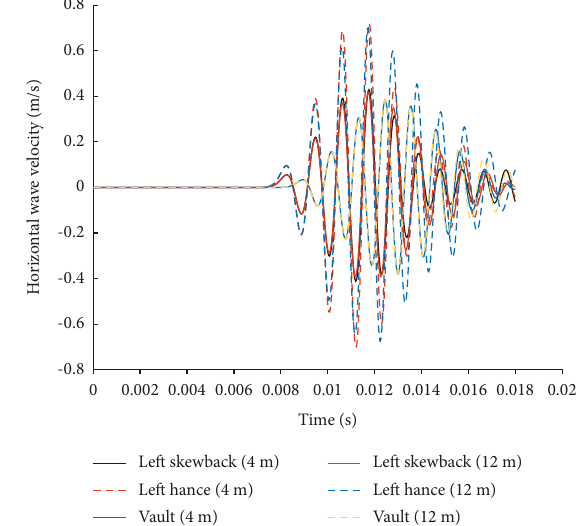
Figure 10: Horizontal wave velocity of each measuring point in tunnel when discontinuity is 4 m and 12m on the left side of tunnel,